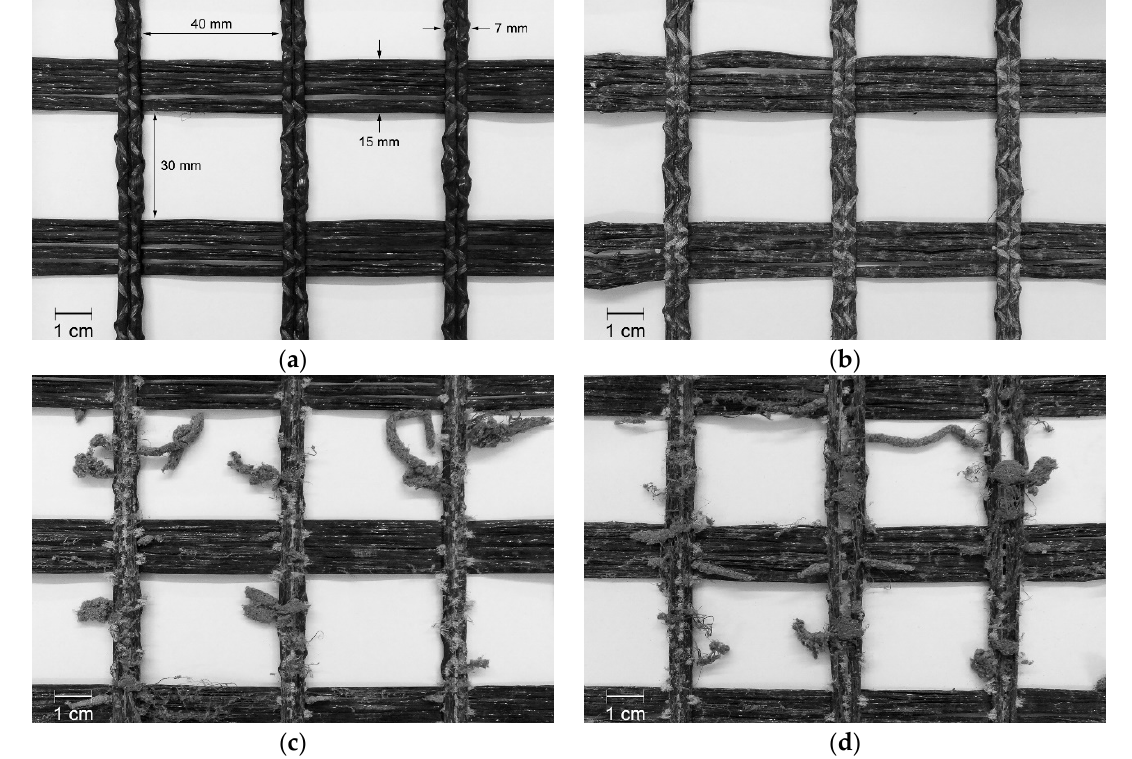
Figure 5. Visual inspection of geogrid GG40I: ( a ) undamaged sample; ( b ) after mechanical damage under repeated loading; ( c ) after abrasion; ( d ) after successive exposure to mechanical damage under repeated loading and abrasion.